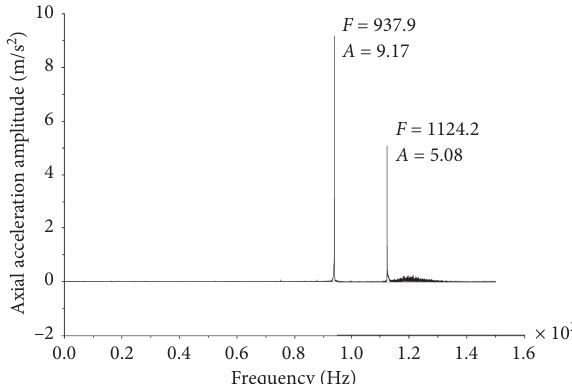
Figure 4: Axial acceleration of the original model.